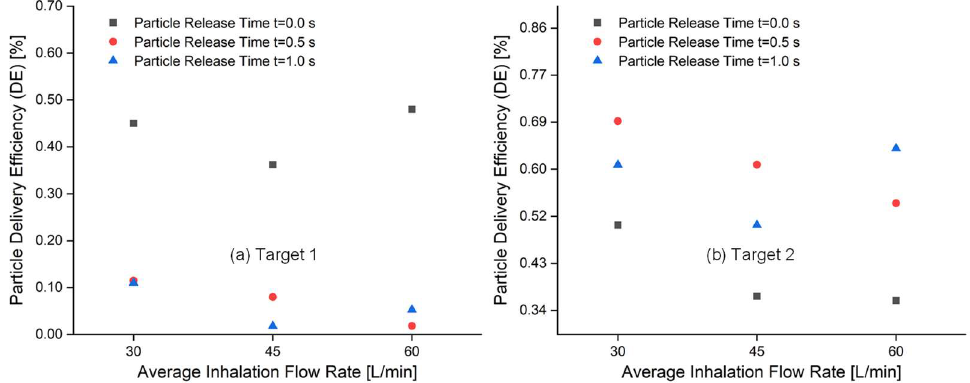
Figure 4. Comparison of targeted particle delivery efficiencies (DEs) for Target 1 and Target 2 using the conventional injection method at varying flow rates and particle release times: ( a ) Target 1, and ( b ) Target 2.